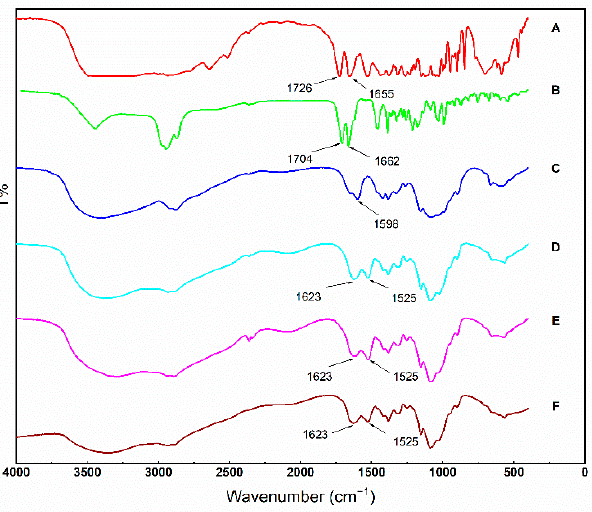
Figure 2. FTIR spectra of sialic acid ( A ), glycyrrhetinic acid ( B ), chitosan ( C ), sialic acid-grafted chitosan ( D ), glycyrrhetinic acid-grafted chitosan ( E ), sialic acid- and glycyrrhetinic acid-grafted chitosan ( F ).